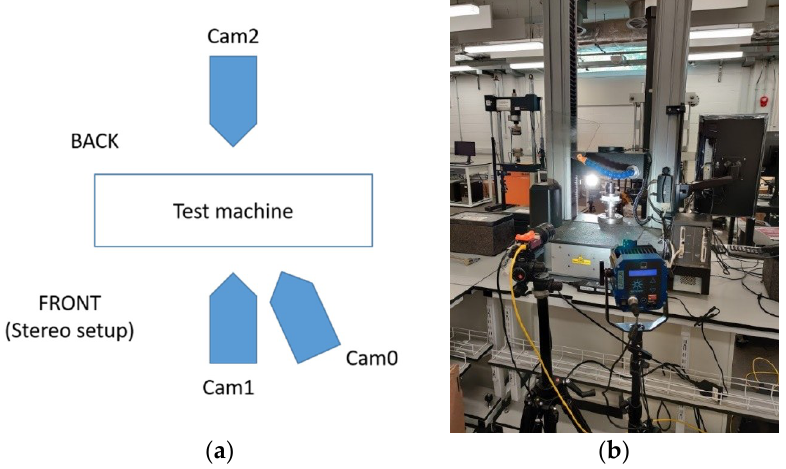
Figure 5. Setup of the optical measurements: ( a ) configuration of cameras on the front and back face; ( b ) cameras recording the front face.